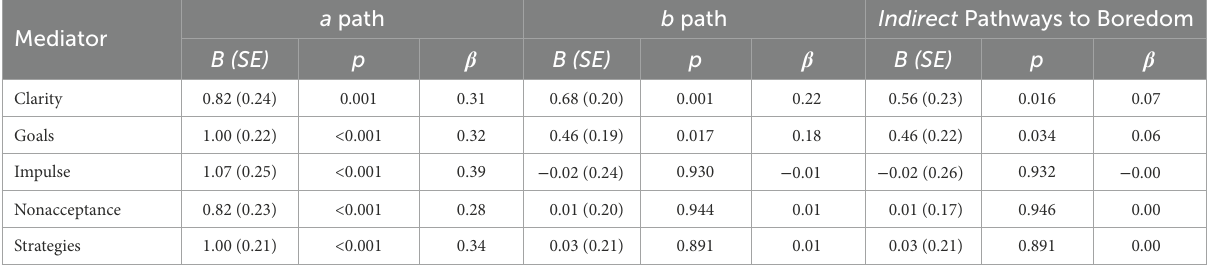
TABLE 5 Exploratory Mediation Analyses Controlling For Boredom Proneness